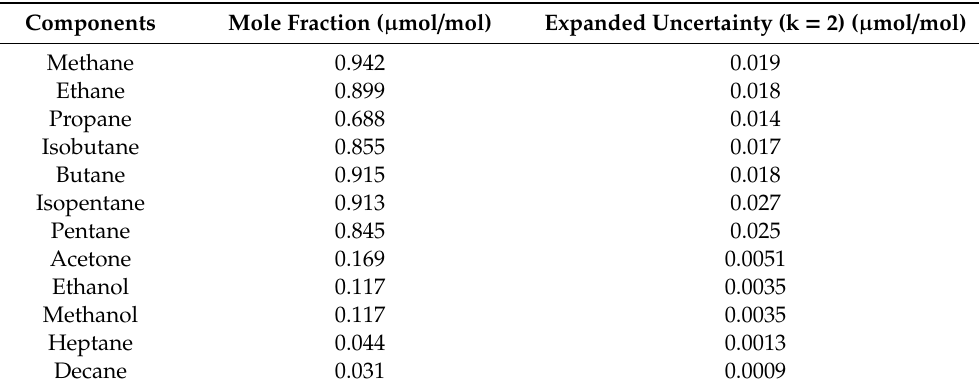
Table 1. Gas mixture used for the short-term stability tests on